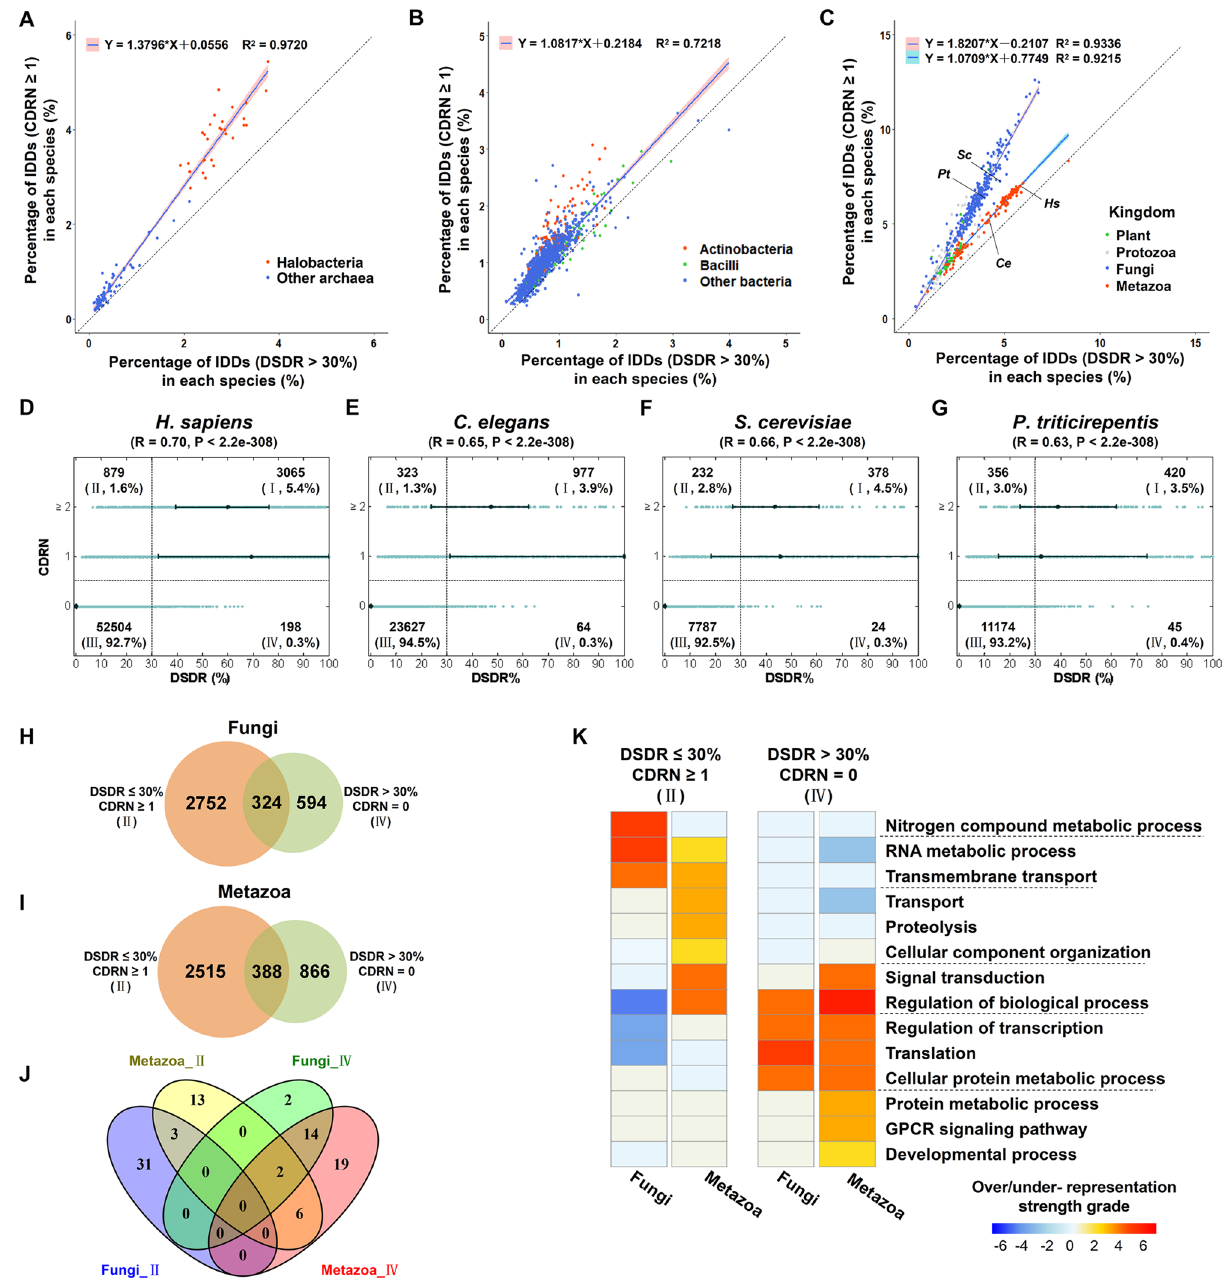
Figure 5. The relationship between DSDR and CDRN and the functions of the special categories. ( A – C ) Scatter plots of the percentage of IDDs in each species of the three superkingdoms ( A , archaea; B , bacteria; C , eukaryotes). Each point represents a species. The dashed diagonal line represents the line where Y and X are equal. The equation in each sub-figure was obtained by fitting a straight line based on the data of all species of archaea ( A ), bacteria ( B ) and fungi or metazoa ( C ). ( D – G ) Scatter plots of the DSDR and CDRN values of the four example eukaryote species. Each point represents a domain. According to the values of DSDR and CDRN, all of protein domains were divided into 4 classes: I, II, III, IV. The sum of the percentages of class I and class IV domains is equivalent to the X value of the corresponding species in sub-figure C; the sum of the percentages of class I and class II domains is equivalent to the Y value of the corresponding species in sub-figure C. ( H – I ) Venn diagrams of the IDDs of the two classes (II, IV) of fungi (H) and metazoa (I). There is an overlap between the two classes because some of IDDs belong to different classes (II, or IV) in different species. ( J ) Venn diagrams of the significantly over-represented BP terms for the two classes (II, IV) of IDDs of fungi and metazoan. ( K ) Over- or under-representation analysis of BPs for the two classes (II, IV) of IDDs of fungi and metazoa. The methods of over- or under- representation analysis and the criterion for strength grading are the same as that of Fig. 3A. The dashed lines separate the significantly over-represented BP terms for each